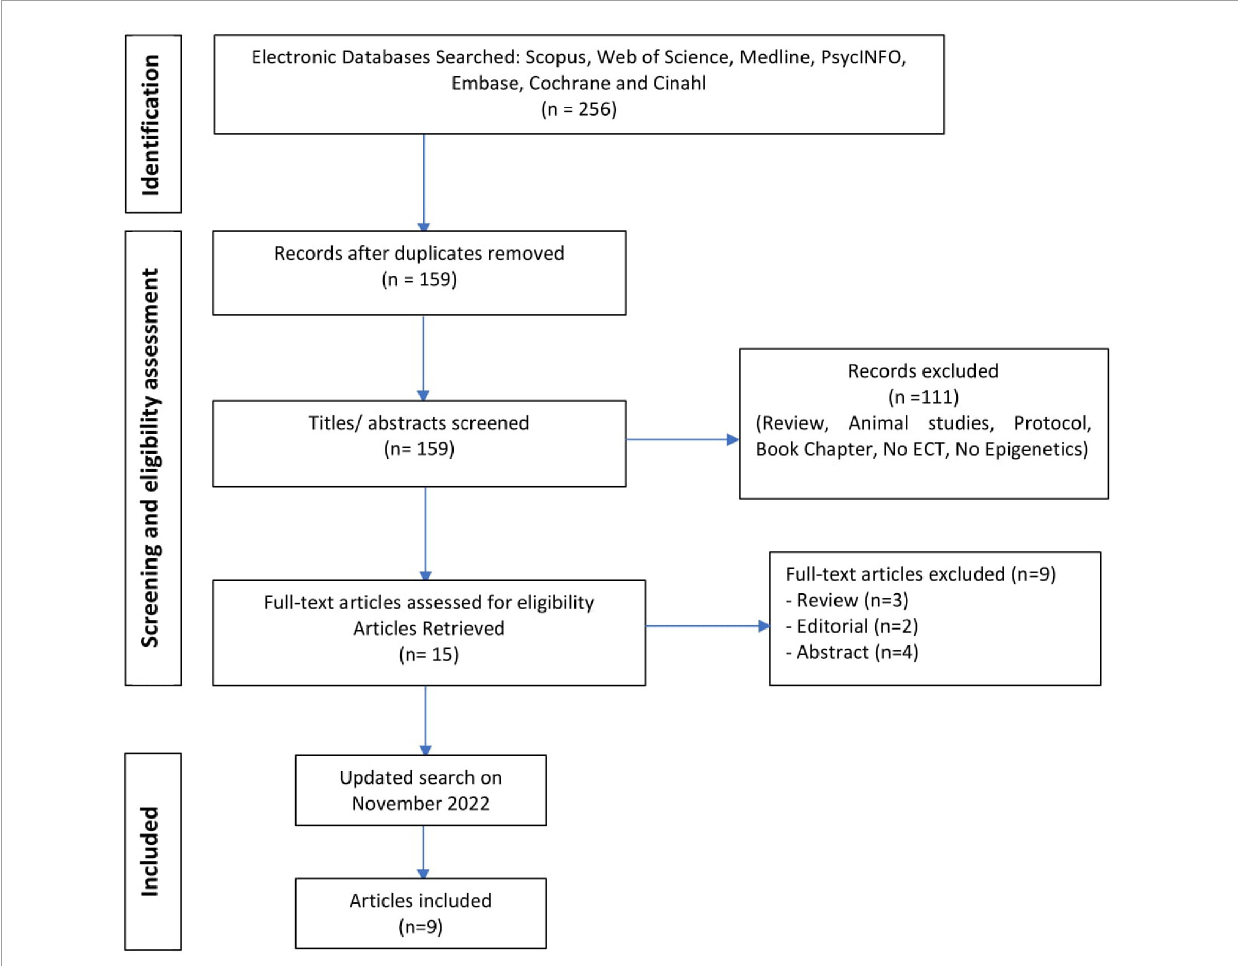
FIGURE1 Preferred Reporting Items for Systematic Reviews (PRISMA) Flow Diagram. The detailed process for selecting articles evaluating the association between epigenetic processes and electroconvulsive therapy (ECT) in